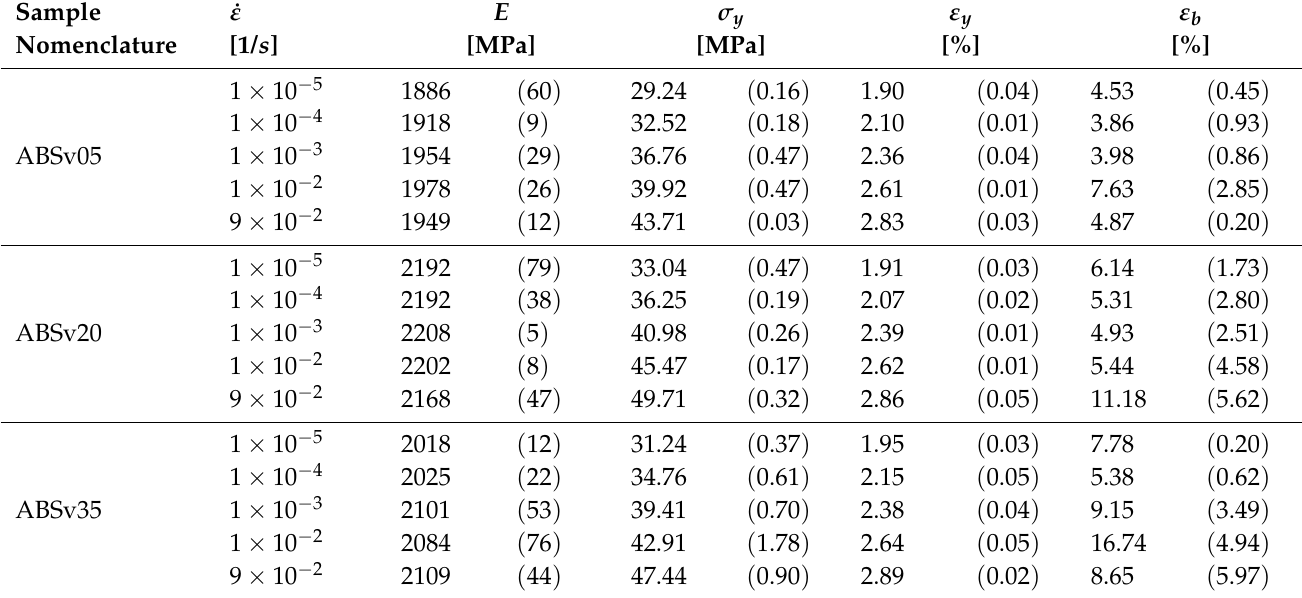
Table 2. Average measured engineering mechanical properties for ME-AM samples. Standard deviations are indicated between